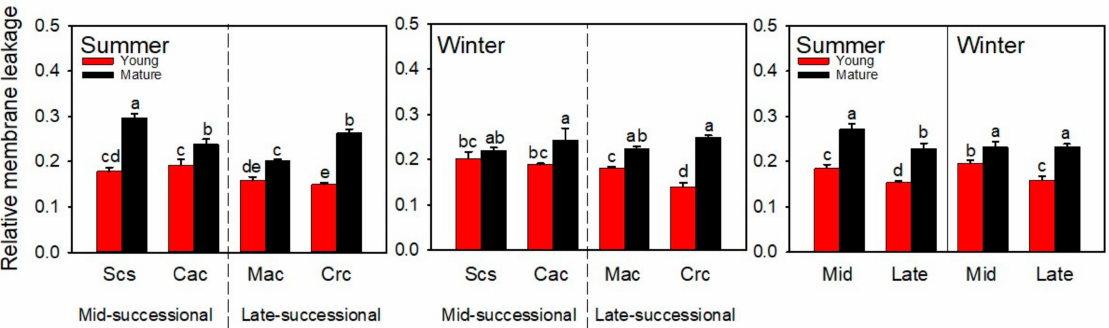
Figure 1. The relative membrane leakage of dominant species at different successional stages in different seasons. Scs, Schima superba ; Cac, Castanopsis chinensis ; Mac, Machilus chinensis ; Crc, Crypto- carya chinensis ; Mid, mid-successional tree group; Late, late-successional species tree group. Different letters above bars indicate statistical significance ( p <